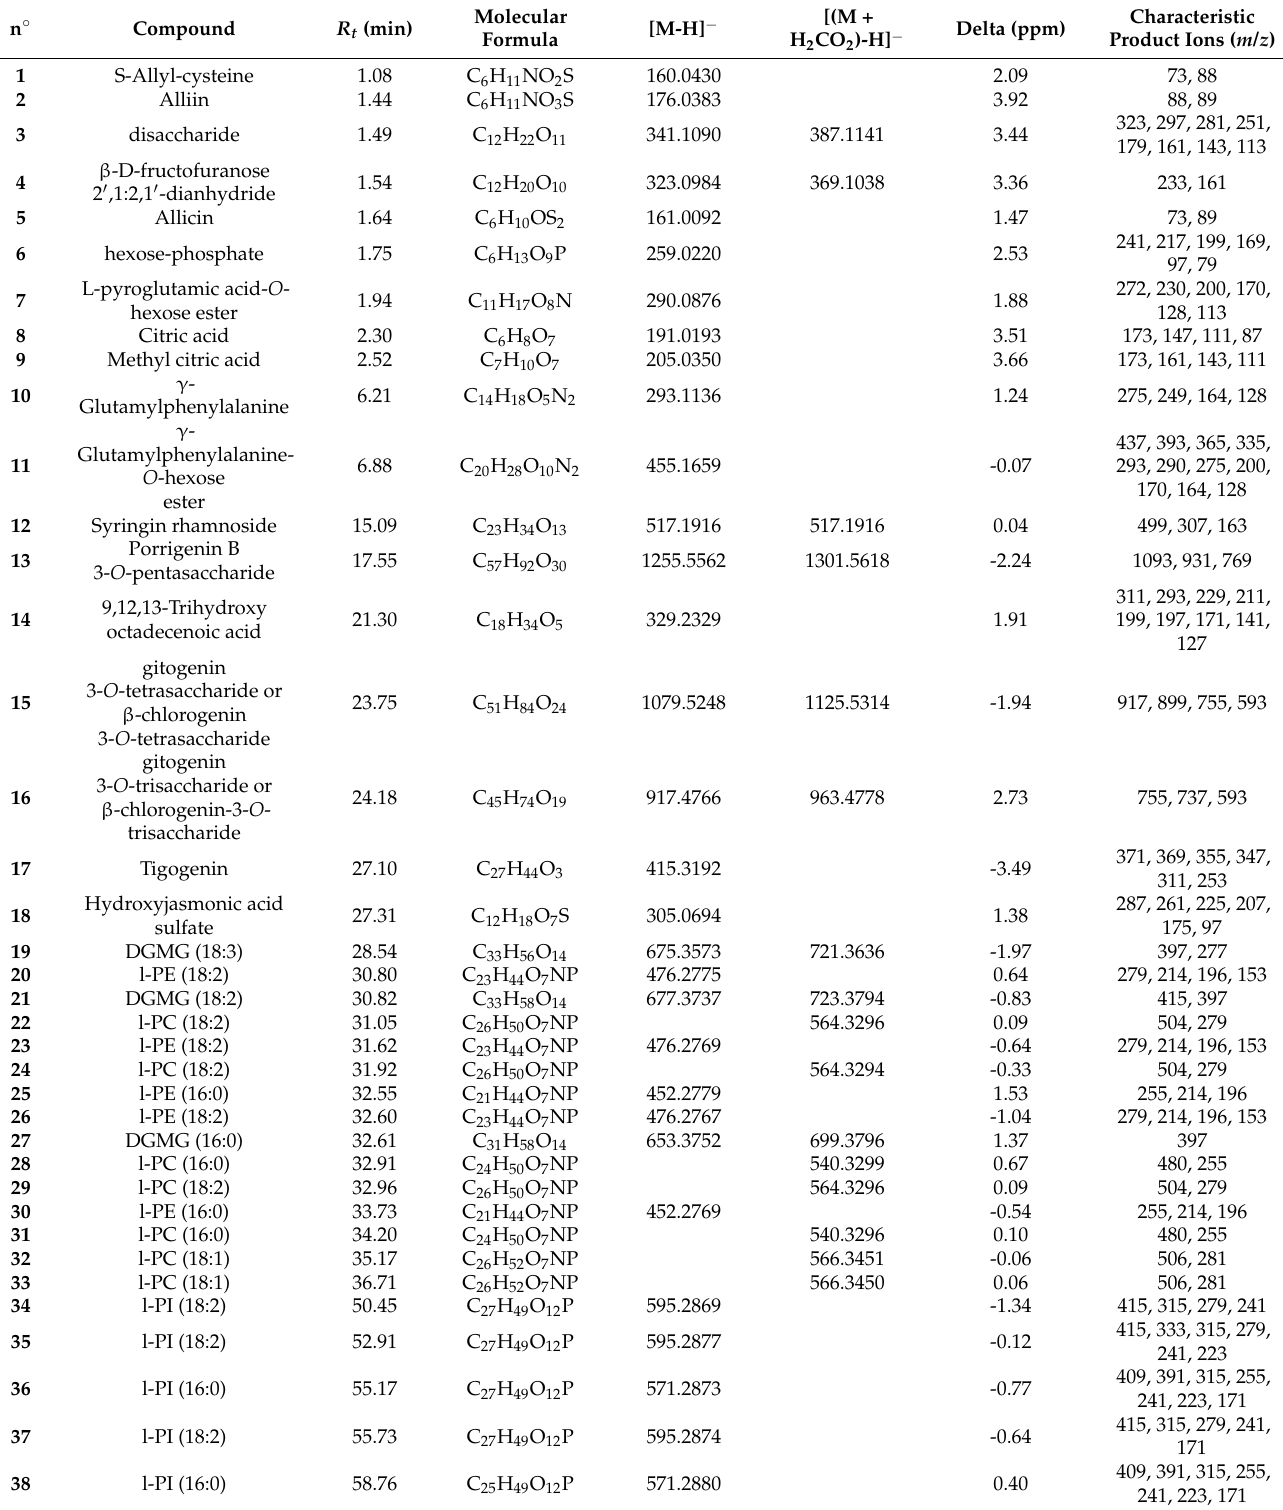
Table 1. LC-ESI/HRMS/MS data and putative identification of metabolites in black garlic methanol extract